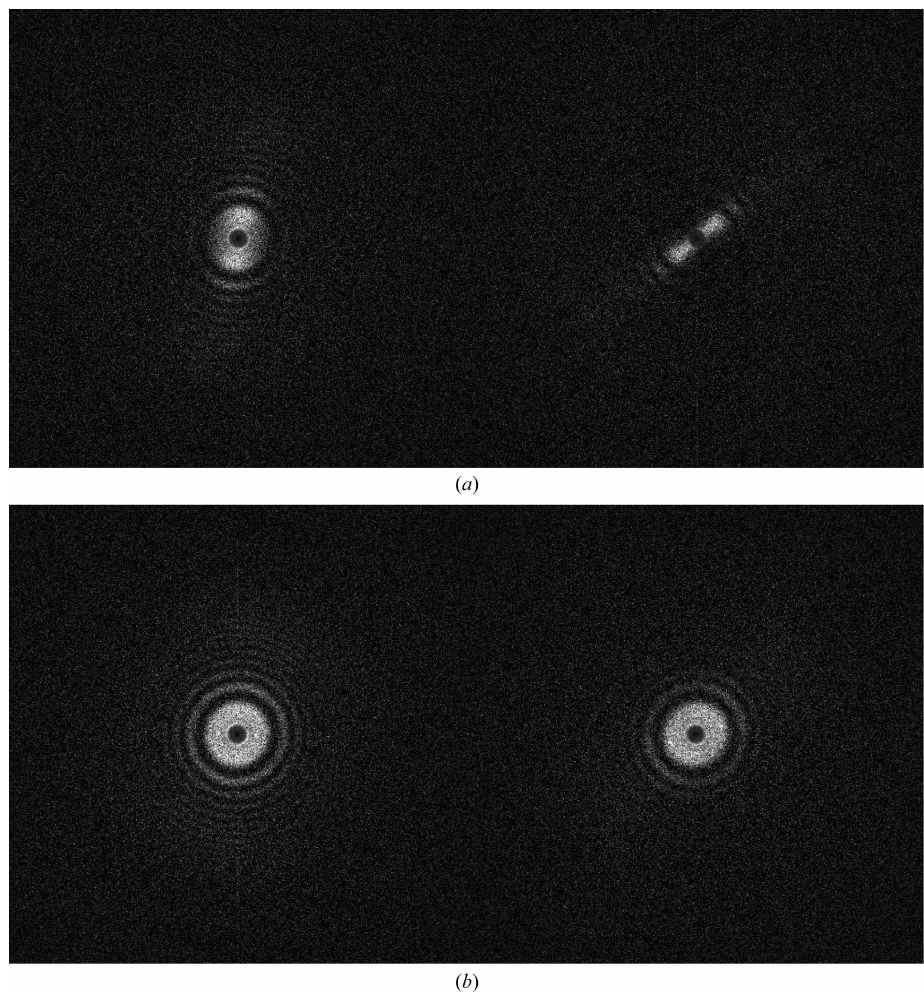
Figure 4 Two spectra of drifted movies: ( a ) before and ( b ) after movie alignments. The second movie in ( a ) experienced a stronger drift, impeding the restoration of the high-resolution information (only two ‘zeroes’ in the direction of the drift were